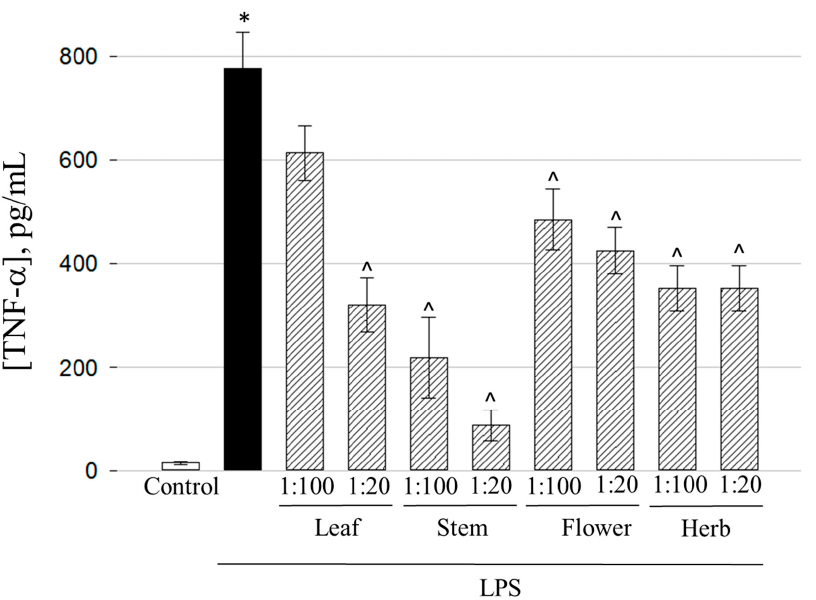
Figure 6. The e ff ect of extracts obtained from di ff erent E. ciliata parts on LPS-induced TNF- α secretion. Figure 6. The effect of extracts obtained from different E. ciliata parts on LPS-induced TNF- α secretion. Results are presented as means ± SD. * significant di ff erence compared to the Control, ˆ compared to Results are presented as means ± SD. * significant difference compared to the Control, ^ compared to the LPS-only treatment ( p < 0.05), one-way ANOVA with Tukey’s the LPS-only treatment ( p < 0.05), one-way ANOVA with Tukey’s test. The concentrations of this cytokine dropped from 775 ± 70 to 87 ± 31 pg/mL in 1:20 dilution case reaching a level 9 times lower compared to LPS-treated samples. At 1:100 dilution, stem ethanolic extract decreased TNF- α level to 219 ± 78 pg/mL, which was 3.5 times lower compared to LPS- stimulated samples. There is a possibility of other non-phenolic compounds being the cause of the results exhibited by the stems extract, because this extract demonstrates the lowest amounts of bioactive compounds like phenolic acids and quercetin glycosides (Tables 1 and 2). Both 1:100 and 1:20 flower extracts demonstrated moderate efficiency decreasing the cytokine level to 485 ± 59 and 425 ± 45 pg/mL, respectively. The predominant compounds in flower extract according to HPLC analysis results were rutin and chlorogenic acid (Tables 1 and 2). The both chemicals are reported to be potent blockers of TNF- α -related inflammatory response [43,44], thus it is likely that rutin and chlorogenic acid might be responsible for prevention of release of this cytokine in our inflammation model. 1:100 leaf extract did not induce significant suppression of LPS-triggered TNF- α release, however at the higher concentration of 1:20, quite an efficient decrease to 321 ± 52 pg/mL was achieved. Similar to the TNF- α case, the most efficient prevention of LPS-induced IL-6 release was demonstrated by 1:20 stem extract of E. ciliata (Figure 7).